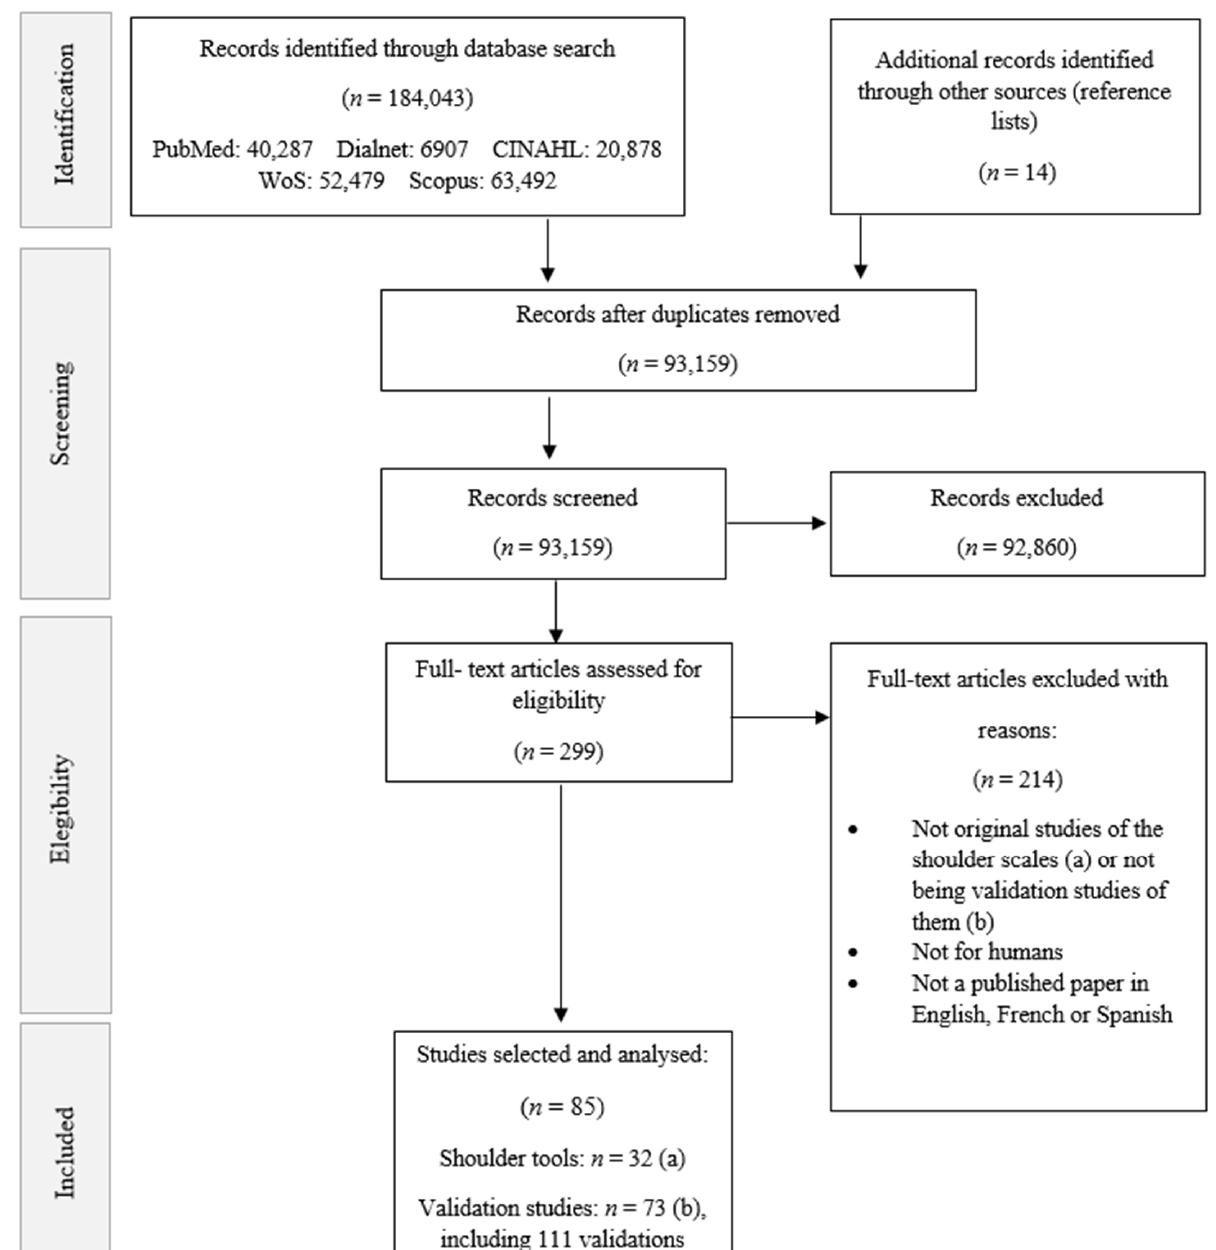
Figure 1. PRISMA flow diagram. Note: Some validations studies validated more than one assessment tool, and a few original studies were not validation